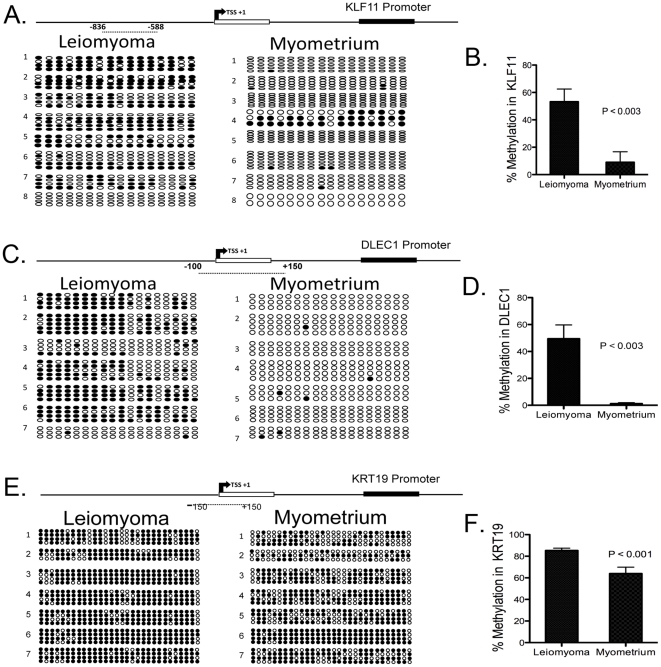
DNA methylation status of KLF11, DLEC1, and KRT19 promoters in uterine leiomyoma and matched myometrial tissues.(A) DNA methylation status of 16 CpG sites in the KLF11 promoter region obtained from bisulfite sequencing of uterine leiomyoma and matched myometrial tissues. The numbers 1 to 8 on the side represent subjects from whom tissues were obtained, (#1–4) subjects were African Americans included in our original genome-wide DNA methylation study and we incorporated 4 new matched samples from Caucasian subjects (#5–8). Black circles represent methylated cytosines and white represent unmethylated cytosines. Numbers indicate the position of cytosine residues of CpGs relative to the transcription start site (+1). (B) Percent DNA methylation of the KLF11 promoter region in uterine leiomyoma and myometrial tissues, P<0.003. (C) DNA methylation status of 18 CpG sites in the DLEC1 promoter region from 3 African American (#1–3) and 4 Caucasian subjects (#4–7). (D) Percent DNA methylation of the DLEC1 promoter region in uterine leiomyoma and myometrial tissues, P<0.003. (E) DNA methylation status of 30 CpG sites in the KRT19 promoter region from 4 African American (#1–4) and 3 Caucasian subjects (#4–7). (F) Percent DNA methylation of the KRT19 promoter region in uterine leiomyoma and myometrial tissues, P<0.001.